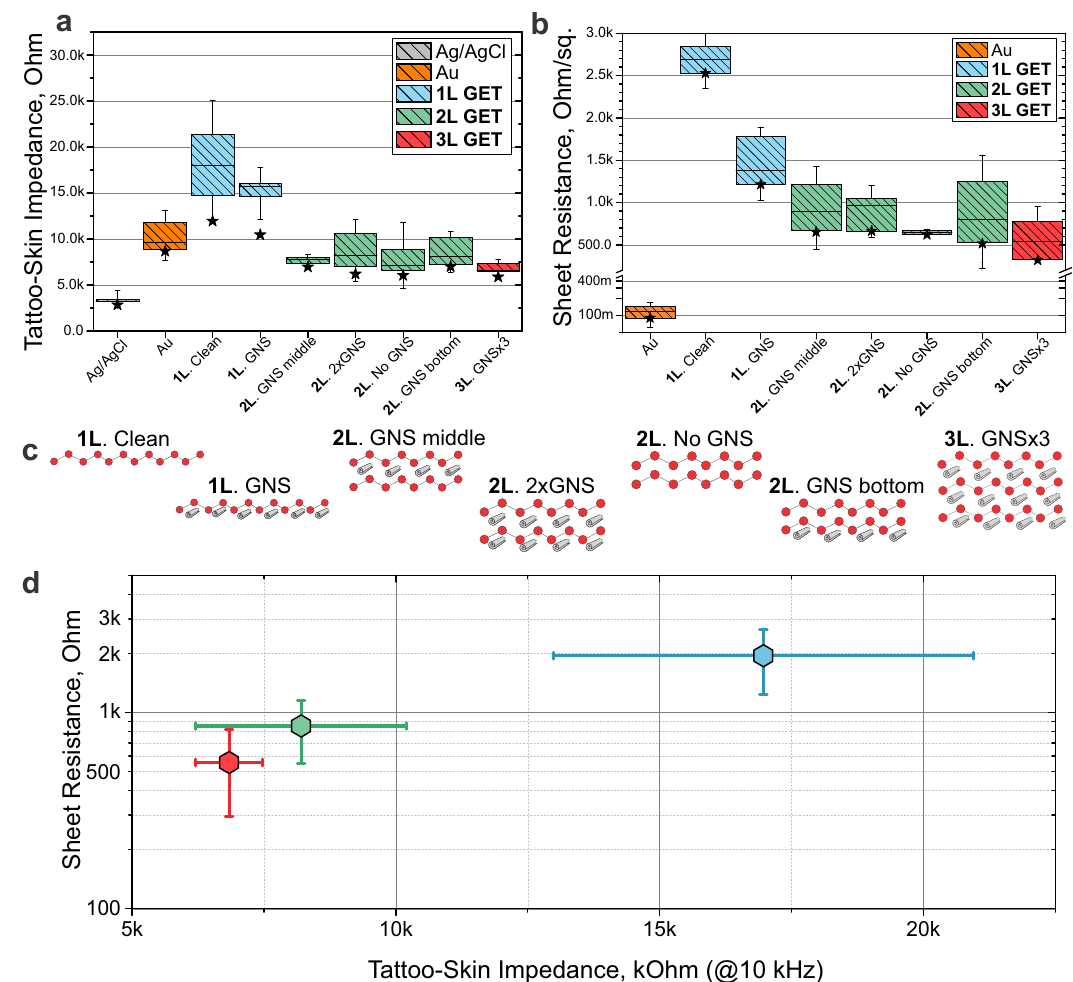
Fig. 1 Graphene layers and effect of nanoscrolls on GETs 2.0 performance. a Statistical average of tattoo-skin Impedance for 7 combinations of GETs and comparison with gold and Ag/AgCl gel electrodes. b Statistical average of GET ’ s sheet resistance for seven combinations of GETs and comparison with gold. 1L-GETs marked in ice blue, 2L-GETs in light green, and 3L-GETs in red. All GETs are 25 mm 2 in area. The box represents 25% and 75% with a mean, whiskers are ±SD, and stars represent the best examples. c The schematic illustration of the GET combinations: 1 L, 2 L, and 3 L with and without GNS. d The performance benchmarking of 1L-GETs (combined), 2L-GETs (combined), and 3L-GETs in terms of sheet resistance and GET-skin